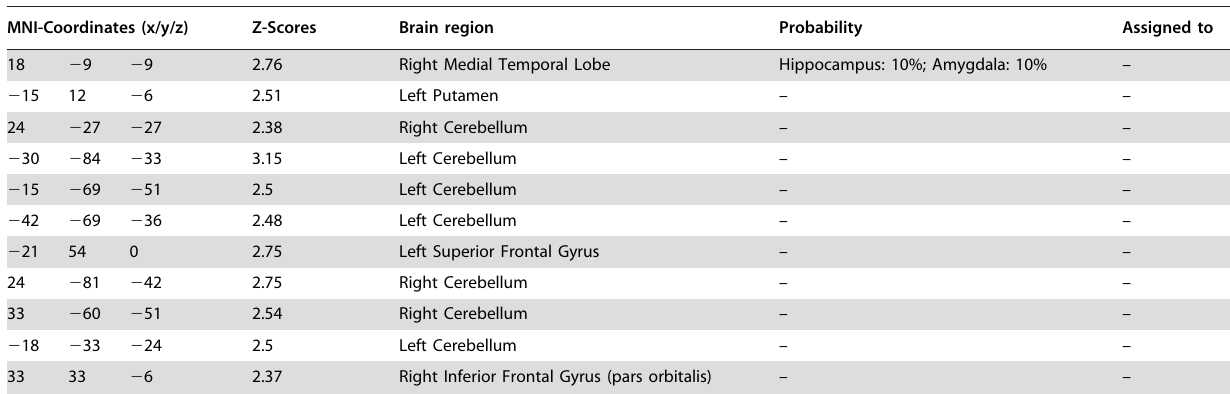
Table 3. Summary of peak locations of BOLD signal change positively correlated to the number of learning trials the subjects needed before reaching the learning criteria (p , 0.05, K . 50, Z-scores . 2.25). .. ... .... ... ... .... ... ... .... ... ... .... ... ... .... ... ... .... ... ... .... ... ... .... ... ... .... ... ... .... ... ... .... ... ... .... ... ... .... ... ... .... ... ... . MNI-Coordinates (x/y/z)